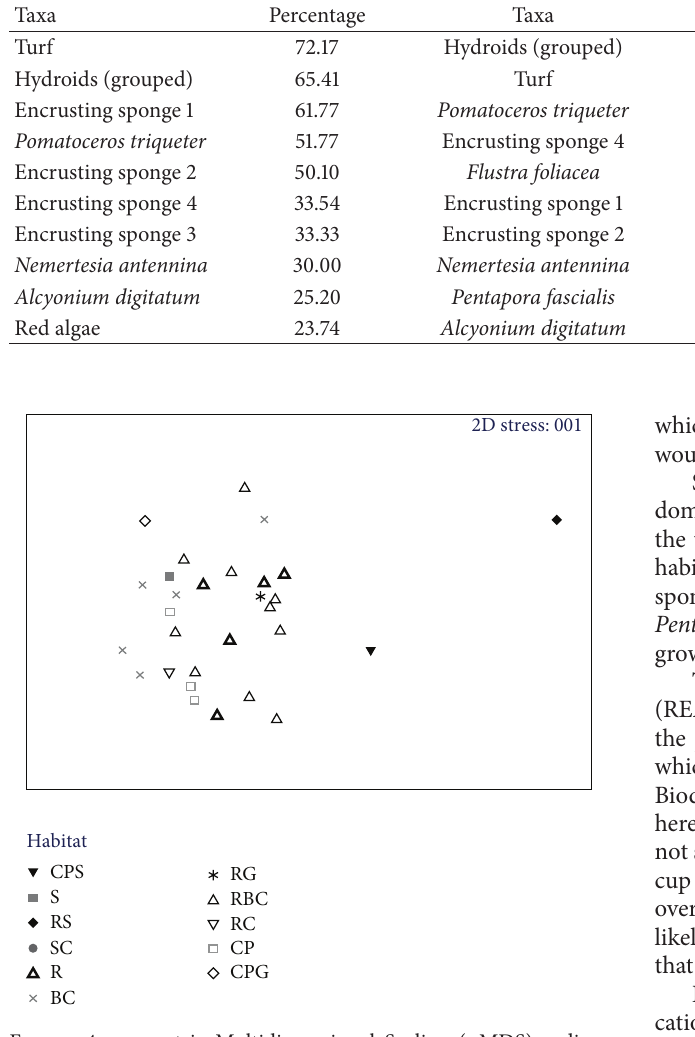
Figure 4: nonmetric Multidimensional Scaling (nMDS) ordina- tion showing the similarities between abundant/encrusting species assemblages at different sites based on habitat type. Habitat type is the dominant type per tow calculated from the frame analysis (R (rock), B (boulders), C (cobbles), P (pebbles), G (gravel), and S